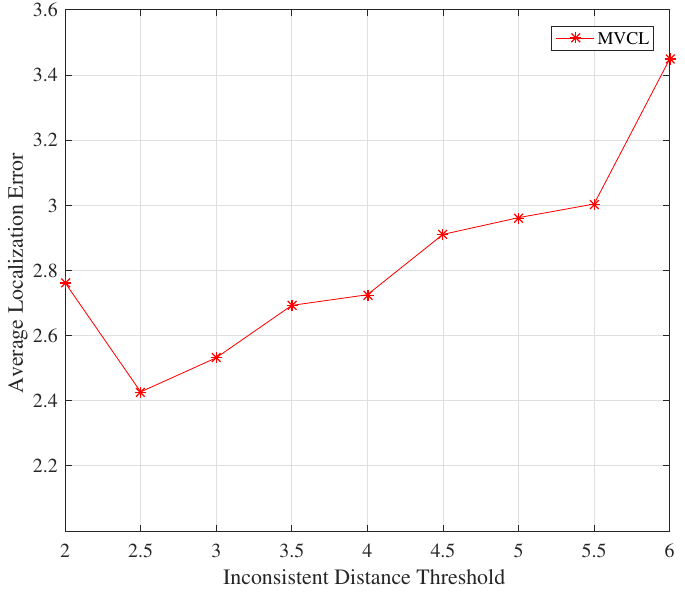
Figure 10. Localization error with inconsistent distance threshold η ( n = 80, m = 20, k = 4, R = 30, ζ =